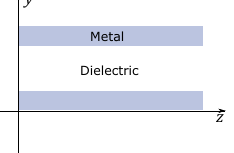
Figure 1. Schematic for a typical multi-layered plasmonic